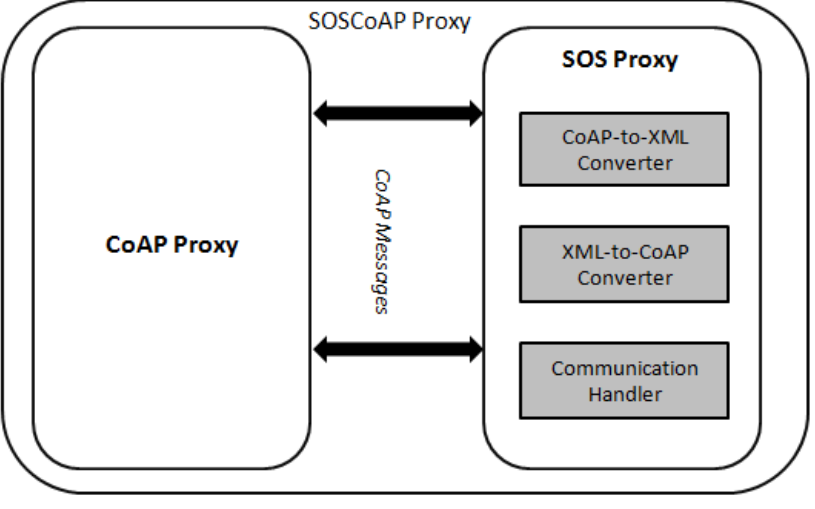
Figure 8. The architecture of the SOSCoAP